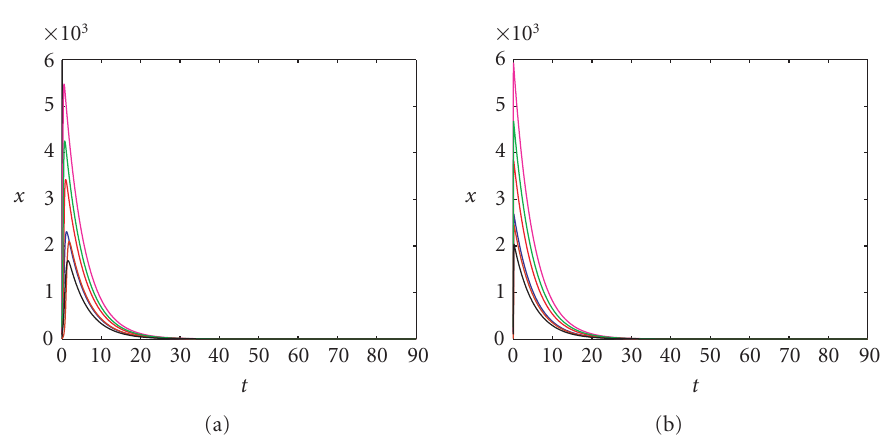
Figure 3.4. (a) Time history of the dynamical system shown in Figure 3.3(b) with a = 0 . 002. (b) Time history of the dynamical system shown in Figure 3.3(b) with a = 0 .